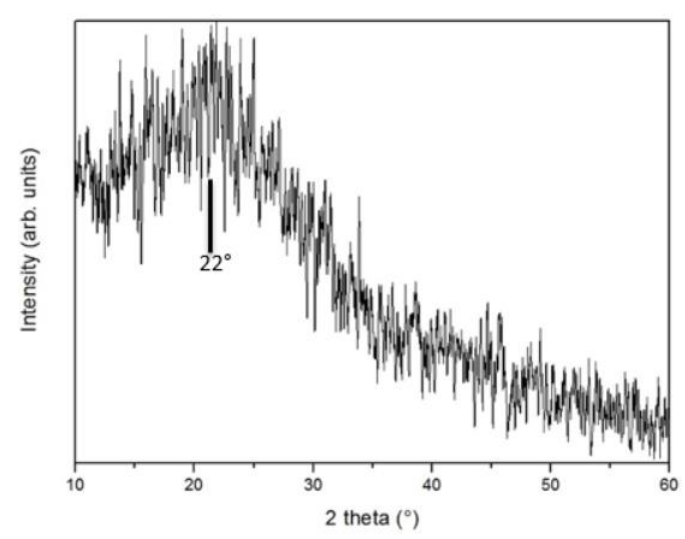
Figure 4. XRD profile of microspheres, showing a wide peak that can be related to the (200) peak of graphite.